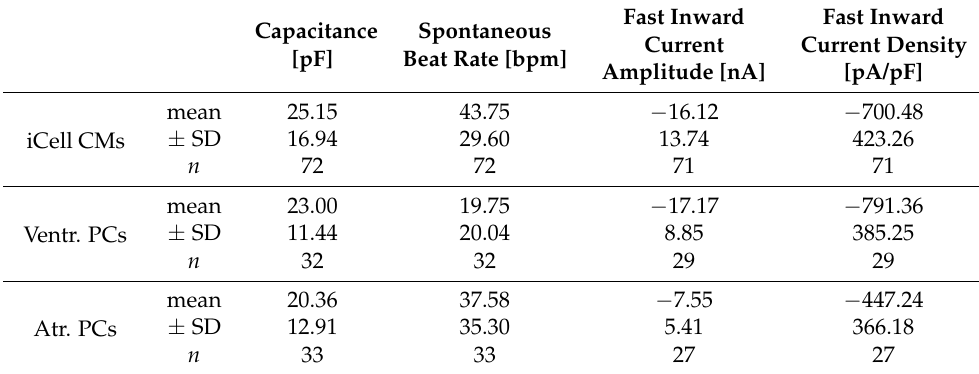
Table 2. Cardiomyocyte electrophysiological measurements. Data are presented as means ± standard deviation (SD) and sample size ( n